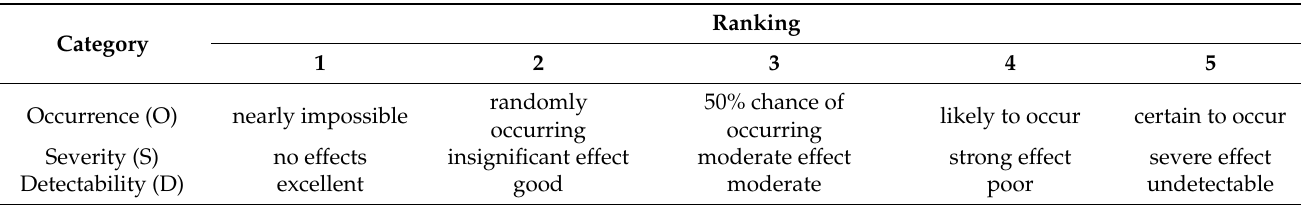
Table 1. Description of